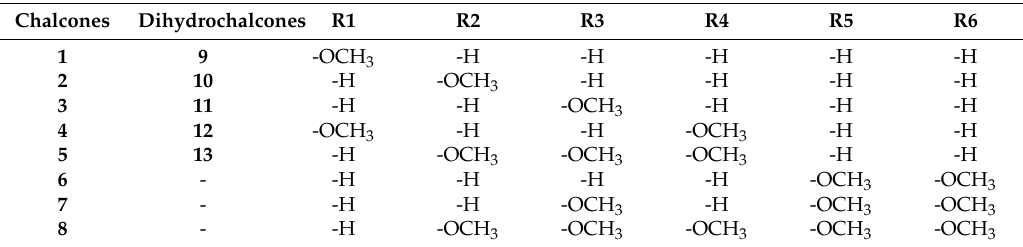
Table 1. Chalcones obtained by chemical synthesis and dihydrochalcones identify as a results of